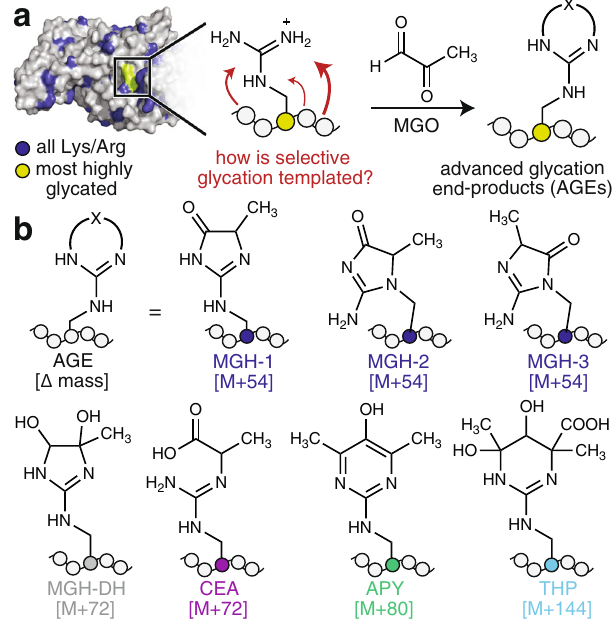
Fig. 1 Glycation is a selective, nonenzymatic PTM. a Glycation is a nonenzymatic post-translational modi fi cation (PTM) that occurs preferentially at certain Arg or Lys residues on certain proteins. For instance, human serum albumin (HSA, PDBID:1E7I) possesses 87 possible glycation sites (blue). Only 12 of these are reported to be glycated, and one site (green), is reported to be the most reactive. Yet, it remains an open question as to how the surrounding microenvironment — a combination of sequence and structure — templates the exact glycation outcome. For instance, the reaction of Arg with methylglyoxal (MGO), one of the most advanced glycation end-products (AGEs). b These include the methylglyoxal-derived hydroimidazolone isomers (MGH-1,-2,-3), dihydroxyimidazolidine (MGH-DH), carboxyethylarginine (CEA), argpyrimidine (APY), and tetrahydropyrimidine